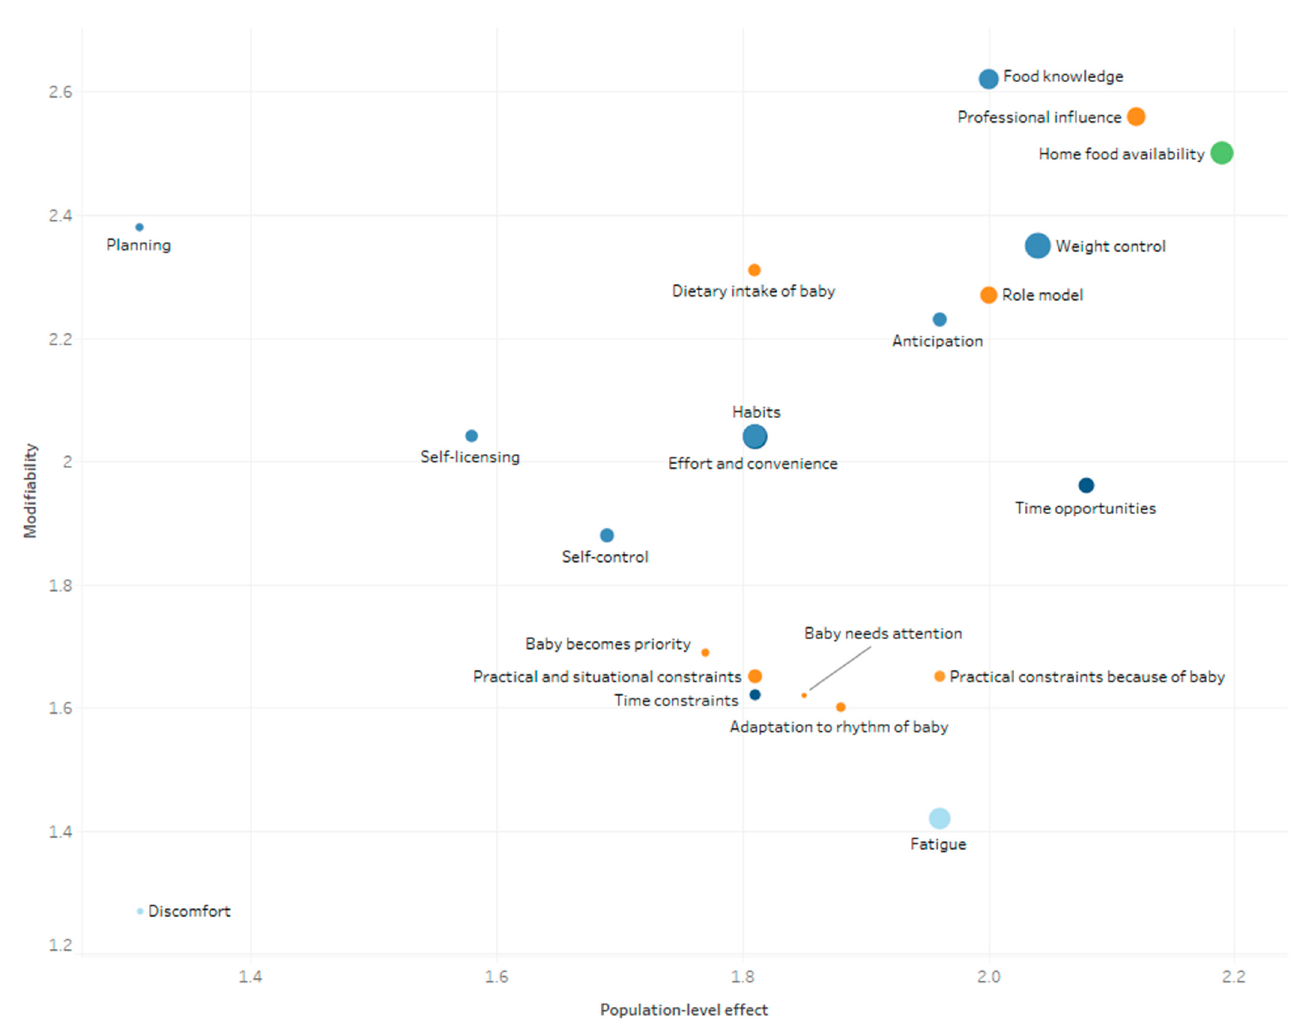
Figure 6. Expert ratings on modifiability, relationship strength, and population-level effect of women’s determinants of changes in eating behavior within the first year postpartum.